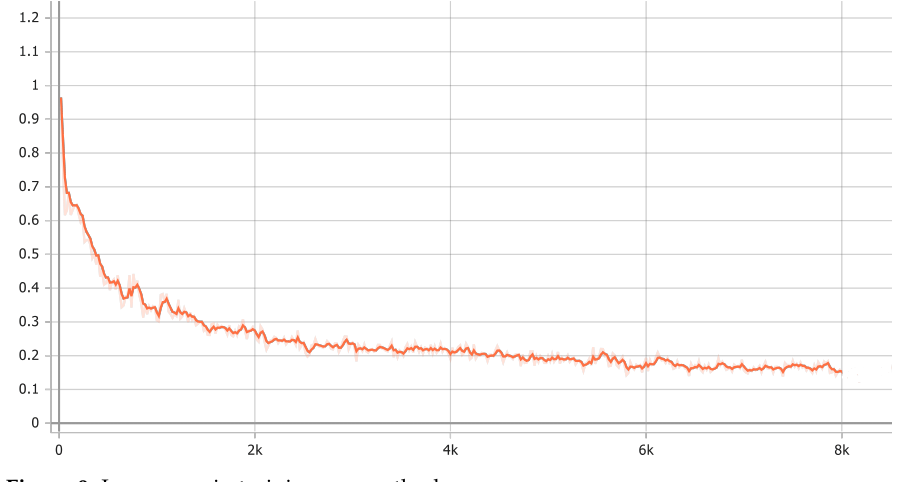
Figure 9. Loss curve in training our